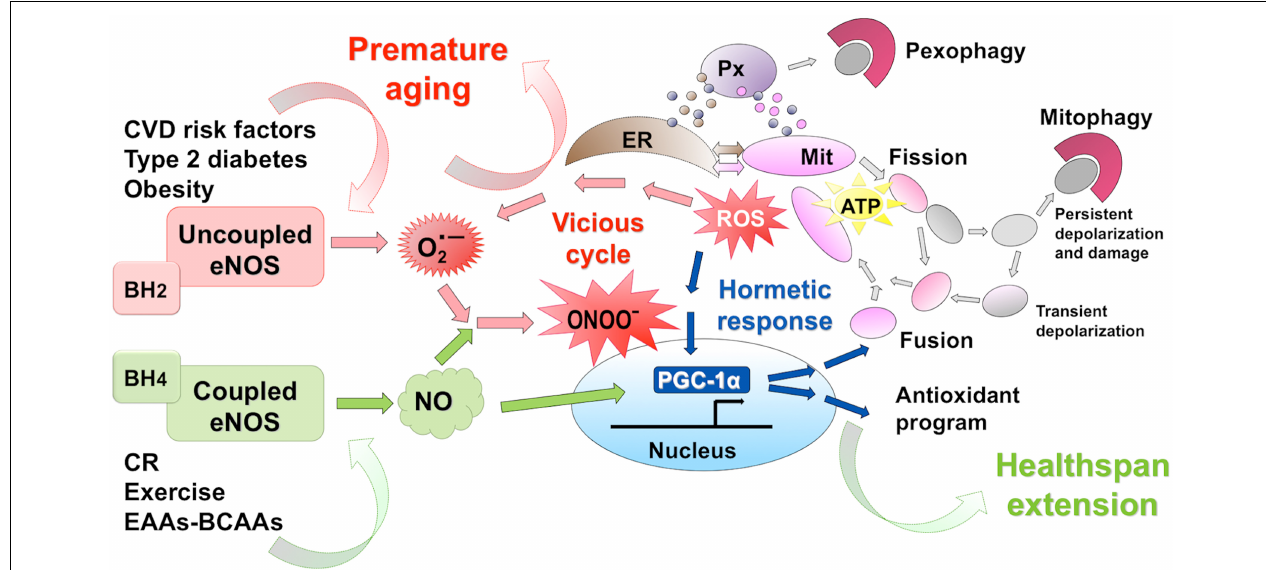
FIGURE 1 | eNOS activation promotes mithormesis and healthspan extension. Calorie restriction (CR) and exercise act as slight stressors favoring low-level ROS production. Further, CR, exercise and dietary supplementation with a balanced BCAA-EAA formula enhance eNOS expression and NO production. The eNOS-NO-PGC1 α pathway boosts mitochondrial renewal, with efficient energy production, and activates the